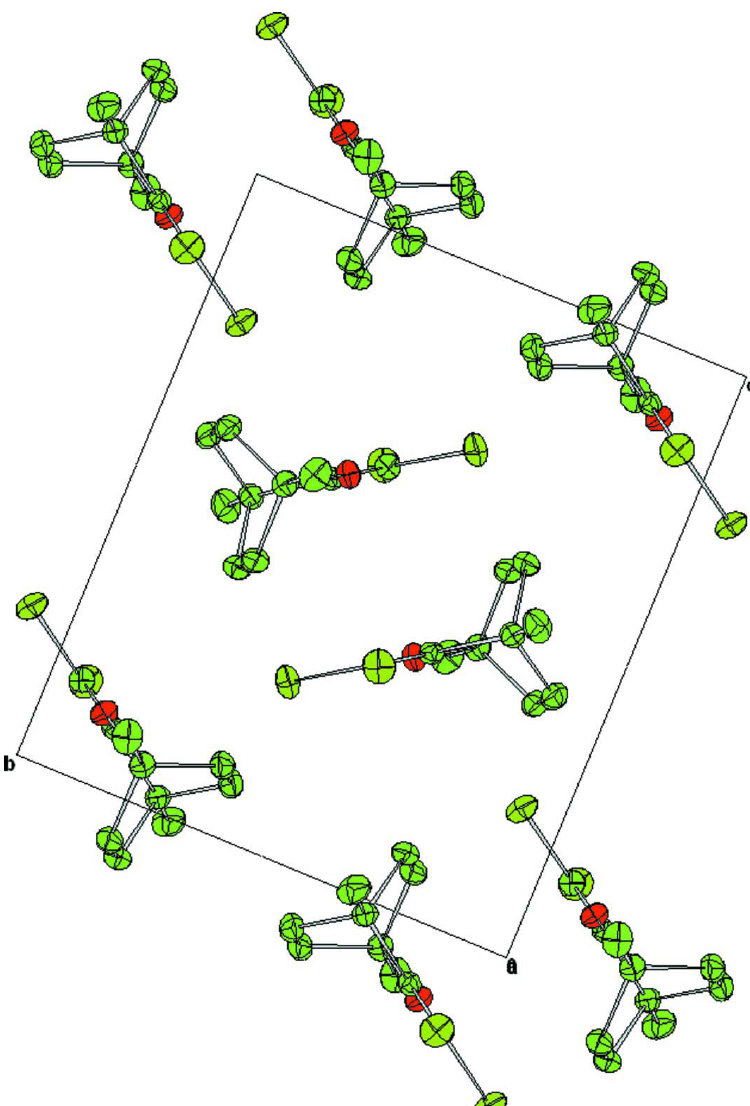
Figure 2 The title compound viewed along the a -axis with H atoms